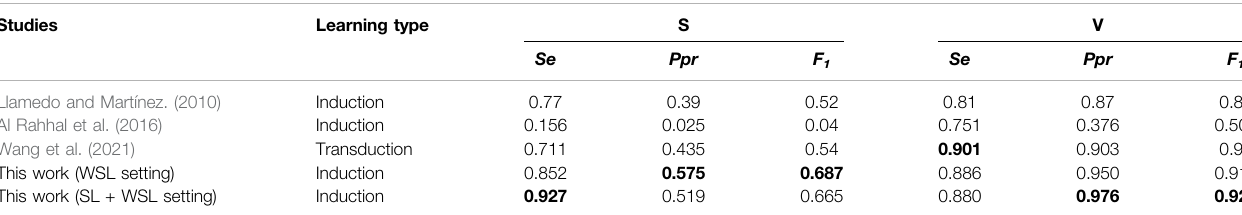
TABLE 6 | Comparison of our method with other studies on the INCART dataset.